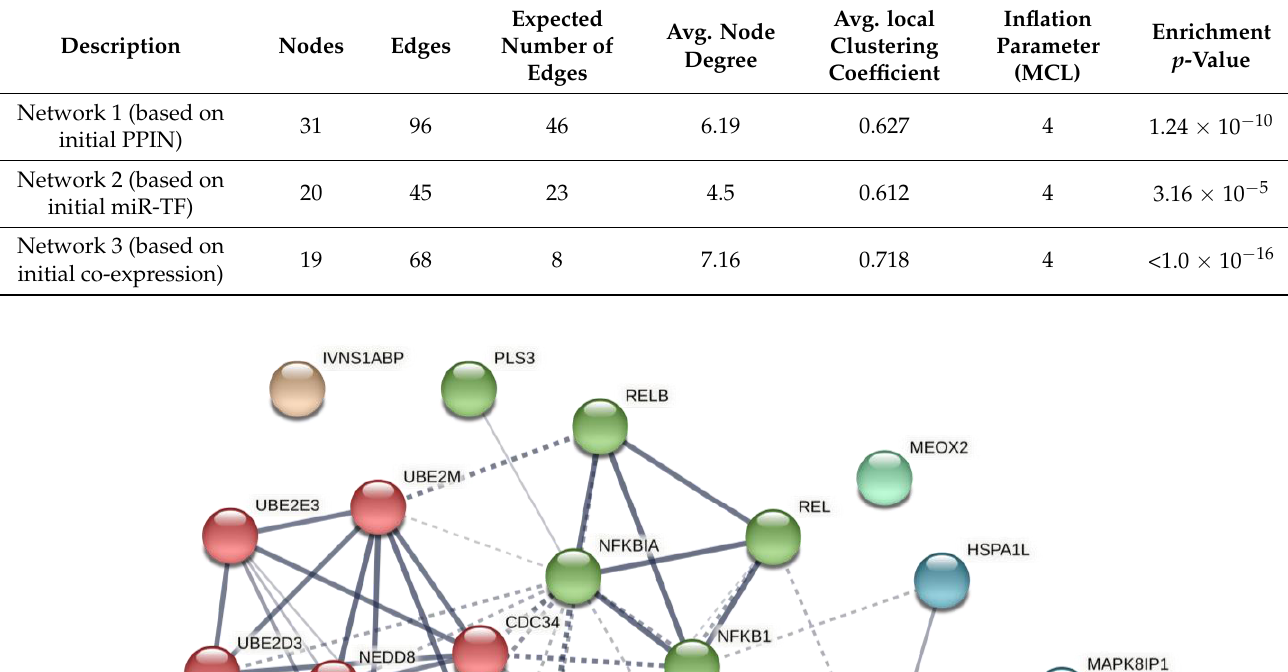
Table 5. Network properties and statistics are presented.